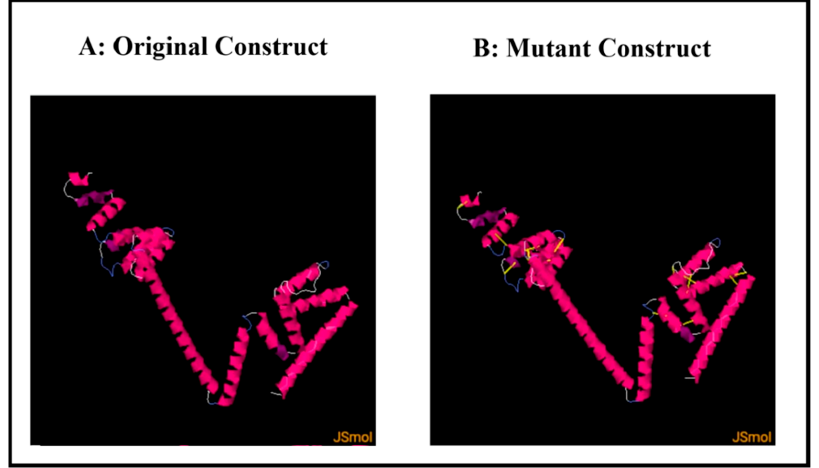
Figure 9. Disulfide engineering results. ( A ) Original MEV construct; ( B ) mutant MEV construct with induced disulfide bonds shown via yellow